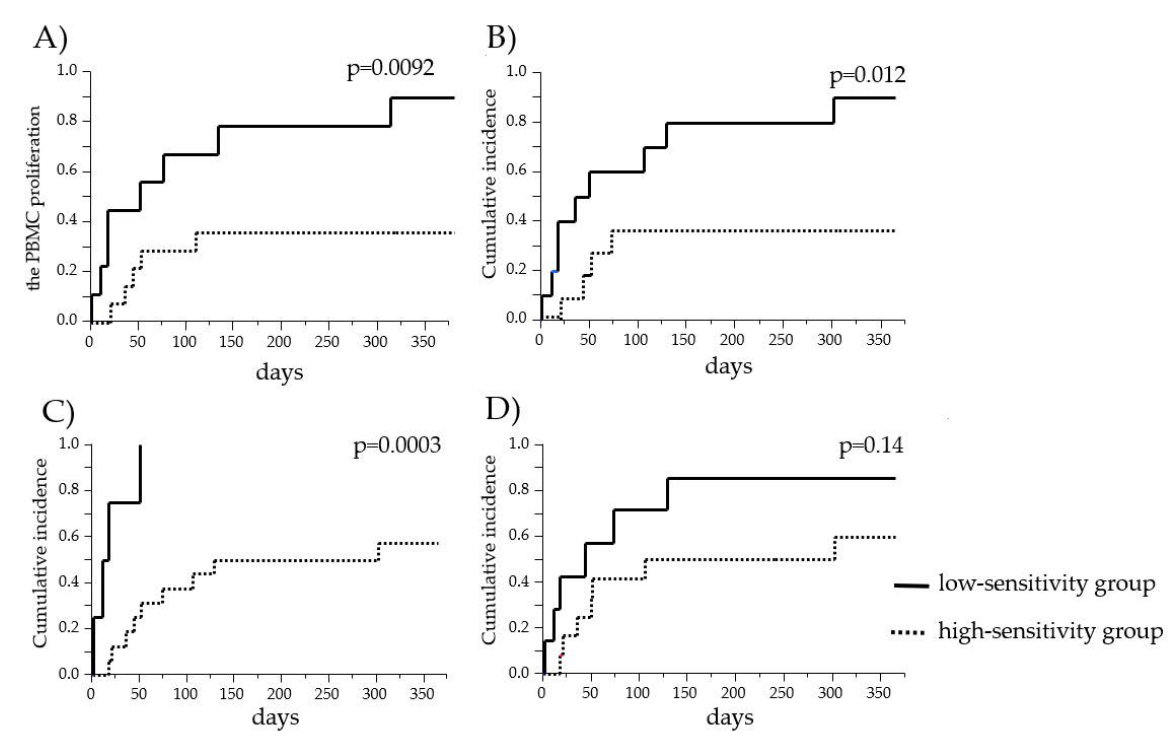
Figure 2. Comparison of the cumulative incidence of GC increase/resumption between the PBMC high-sensitivity group and the PBMC low-sensitivity group to GCs. The cumulative incidences of the increase/resumption of GC administrations in the PBMC high-sensitivity group and the PBMC low-sensitivity group to COR before transplantation ( A ), MPSL before transplantation ( B ), COR after transplantation ( C ), and MPSL after transplantation ( D ) were estimated. The solid lines and dashed lines indicate the data for the low-sensitivity and high-sensitivity groups,